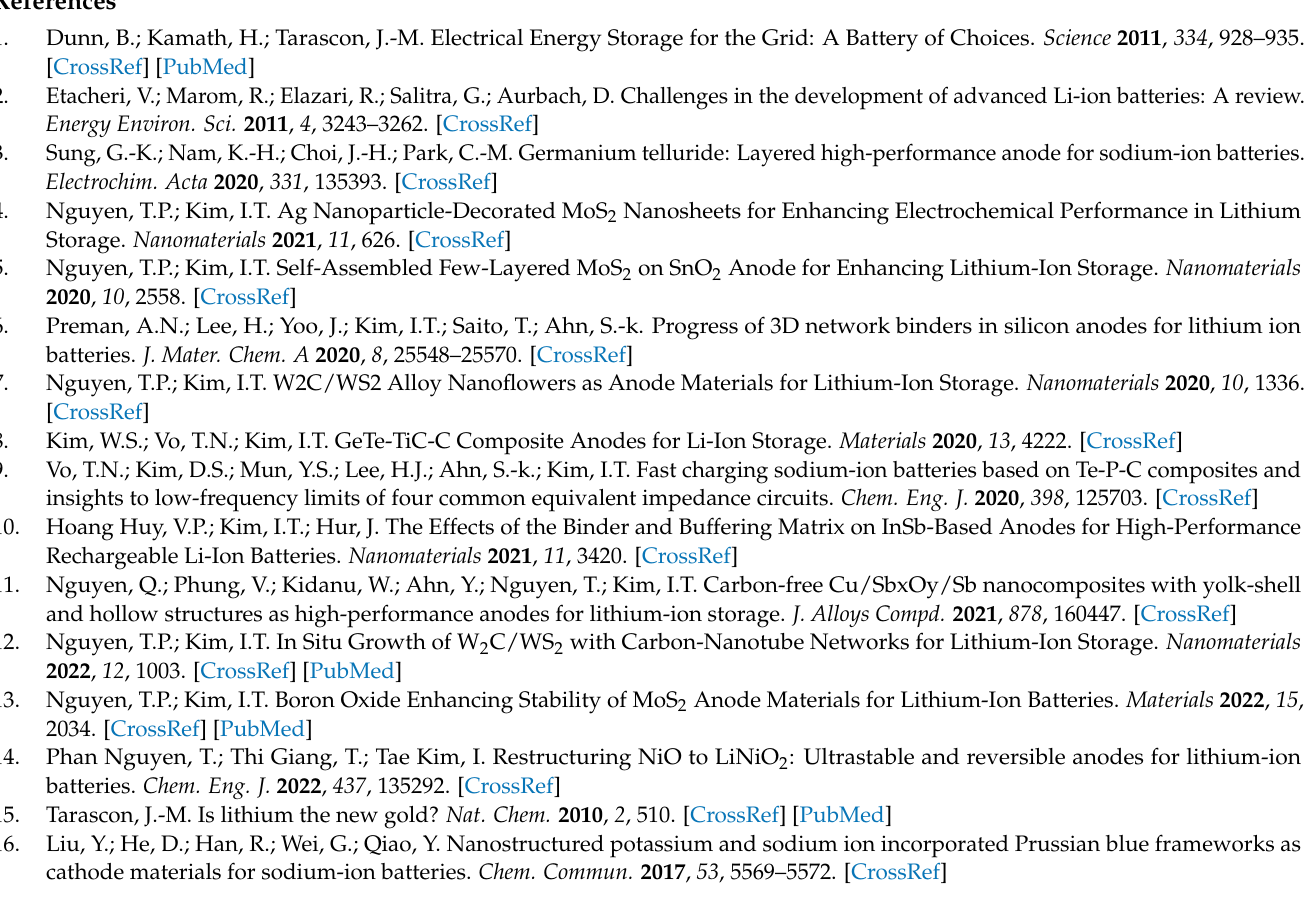
SIB. Table S6: Coulombic efficiency of Ga 2 Te 3 –TiO 2 –C at current density of 100 mA g − 1 during initial 10 cycles for SIB. Table S7: Coulombic efficiency of Ga 2 Te 3 –TiO 2 –C at current density of 500 mA g − 1 during initial 10 cycles for SIB. Table S8: Charge-transfer resistance (Rct) of Ga 2 Te 3 –TiO 2 –C for